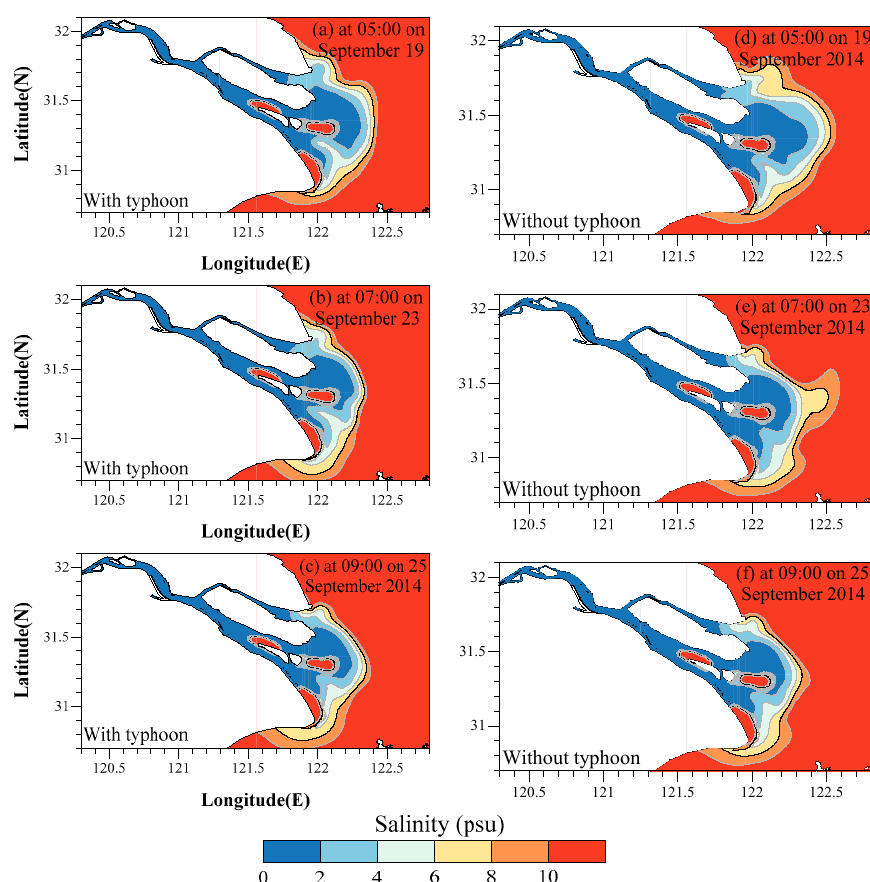
Figure 13. With typhoon and without typhoon. Surface salinity distribution at ( a ) 5:00 on 19 September in the rising period; ( b ) 7:00 on 23 September in the stable period; ( c ) and 9:00 on 25 September 2014 in the falling period of Typhoon Fongwong, and the same time-surface salinity distribution ( d–f ) without typhoon.